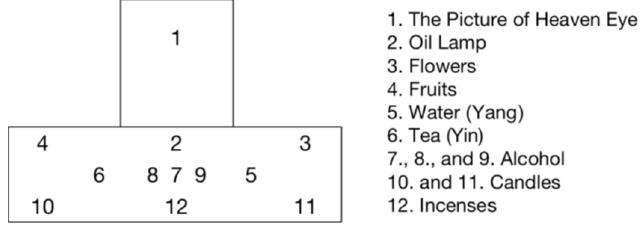
Figure 3. Ritual arrangement of the offering table for Master Cao Đ ài ( Bàn Th ờ Th ầ y ).